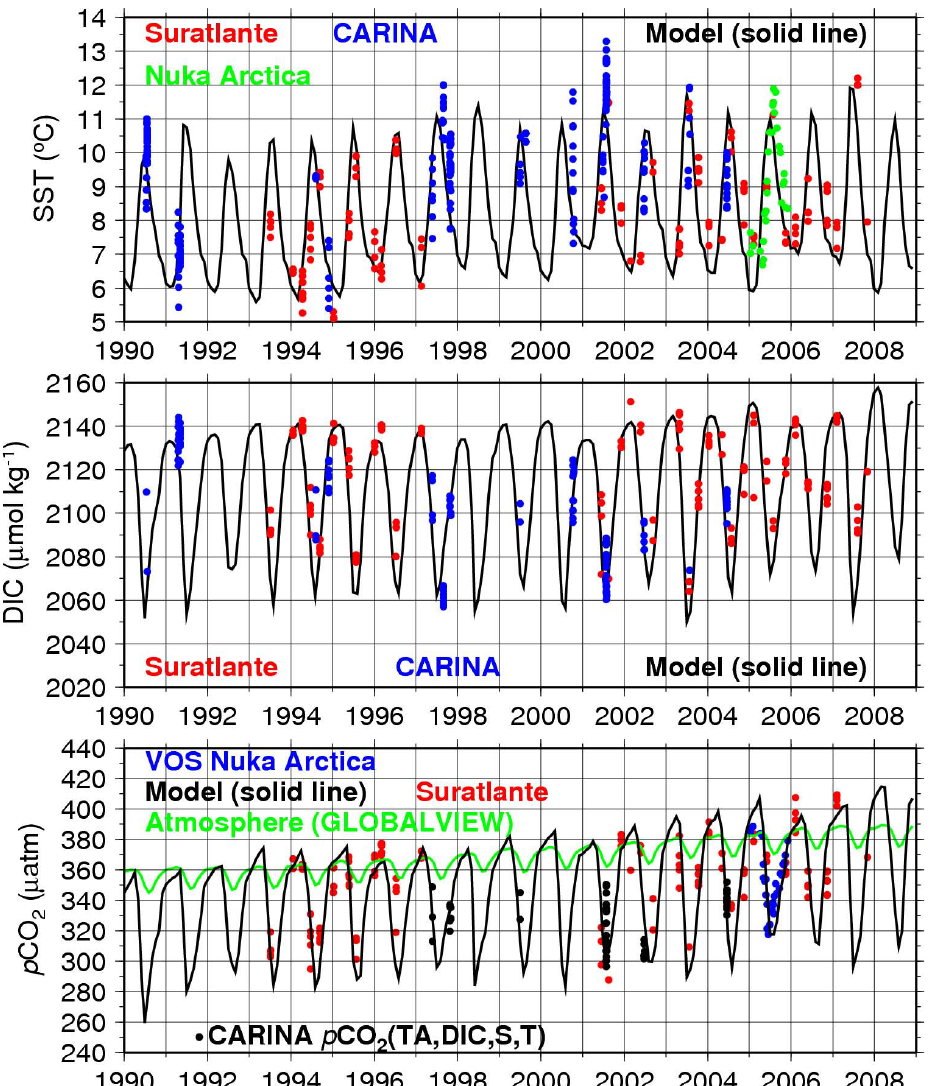
Fig. 10. Time series of model SST and surface ocean DIC and p CO 2 . Corresponding in situ measurements are shown with their diverse origin color-coded. The surface ocean p CO 2 (bottom tier) also shows the GLOBALVIEW atmospheric p CO 2 and the ocean p CO 2 , derived from CARINA TA, DIC, temperature and